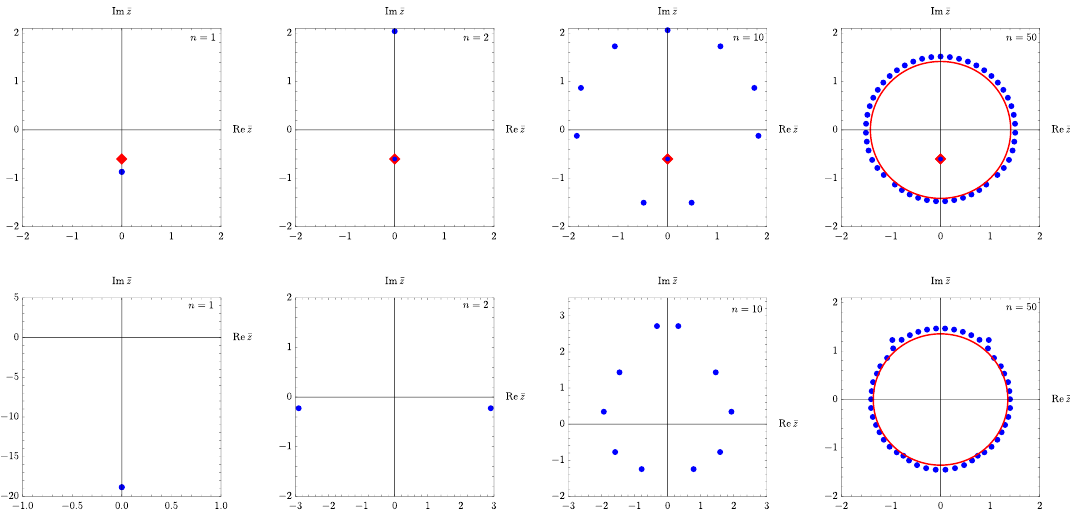
Figure 12 . The distribution of roots of the equation ¯ ω 0 (¯ z ) = 0 truncated at orders n = { 1 , 2 , 10 , 50 } of the hydrodynamic gradient expansion. Top panel: here, we show the example of the longitudinal sound mode in N = 4 SYM theory. In the four plots, the red diamond represents the location of the self-intersection point ¯ z g . We see that already at order n = 2 , the location of one of the roots is virtually indistinguishable from the exact value of ¯ z g . The spurious poles organise themselves along √ the radius of convergence | ¯ z | = ¯ R = 2 , depicted as a red circle in the last plot ( n = 50 ). Bottom panel: here, we show the example of the Case III L of the holographic solid model (cf. table 2). The spurious roots (all roots) converge to the boundary of D R , with ¯ R = 1 . 36 , again depicted as a red circle in the last plot ( n = 50